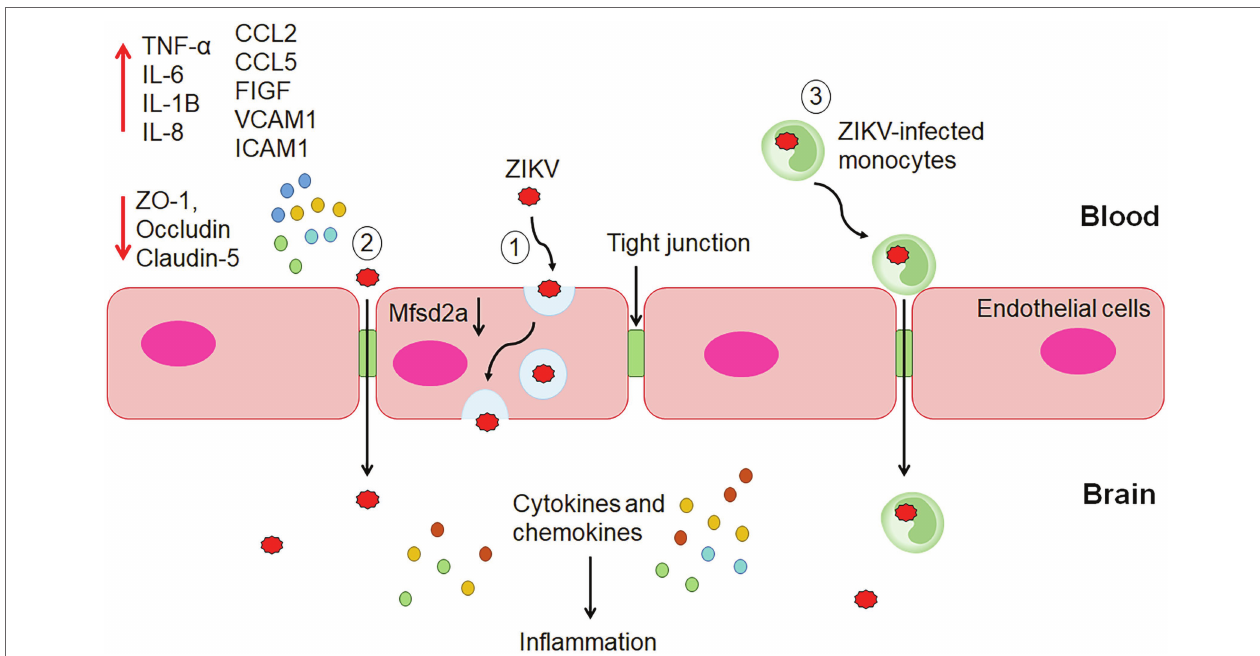
FIGURE 1 | The proposed mechanisms of ZIKV invasion into the central nervous system (CNS). (1) Transcellular transport within endothelial cells of the BBB through infection or transcytosis mediated by ZIKV-induced degradation of Mfsd2a. (2) Paracellular trafficking of ZIKV across the blood–brain barrier (BBB) occurs through the upregulation of proinflammatory cytokines, chemokines, adhesion molecules and growth factors, and downregulation of tight junction proteins leading to alteration of the endothelial barrier integrity and permeability. (3) ZIKV-infected monocytes cross the BBB via the Trojan horse strategy. Once reach the CNS, ZIKV infects the brain cells, including astrocytes and microglial cells producing cytokines and chemokines leading to